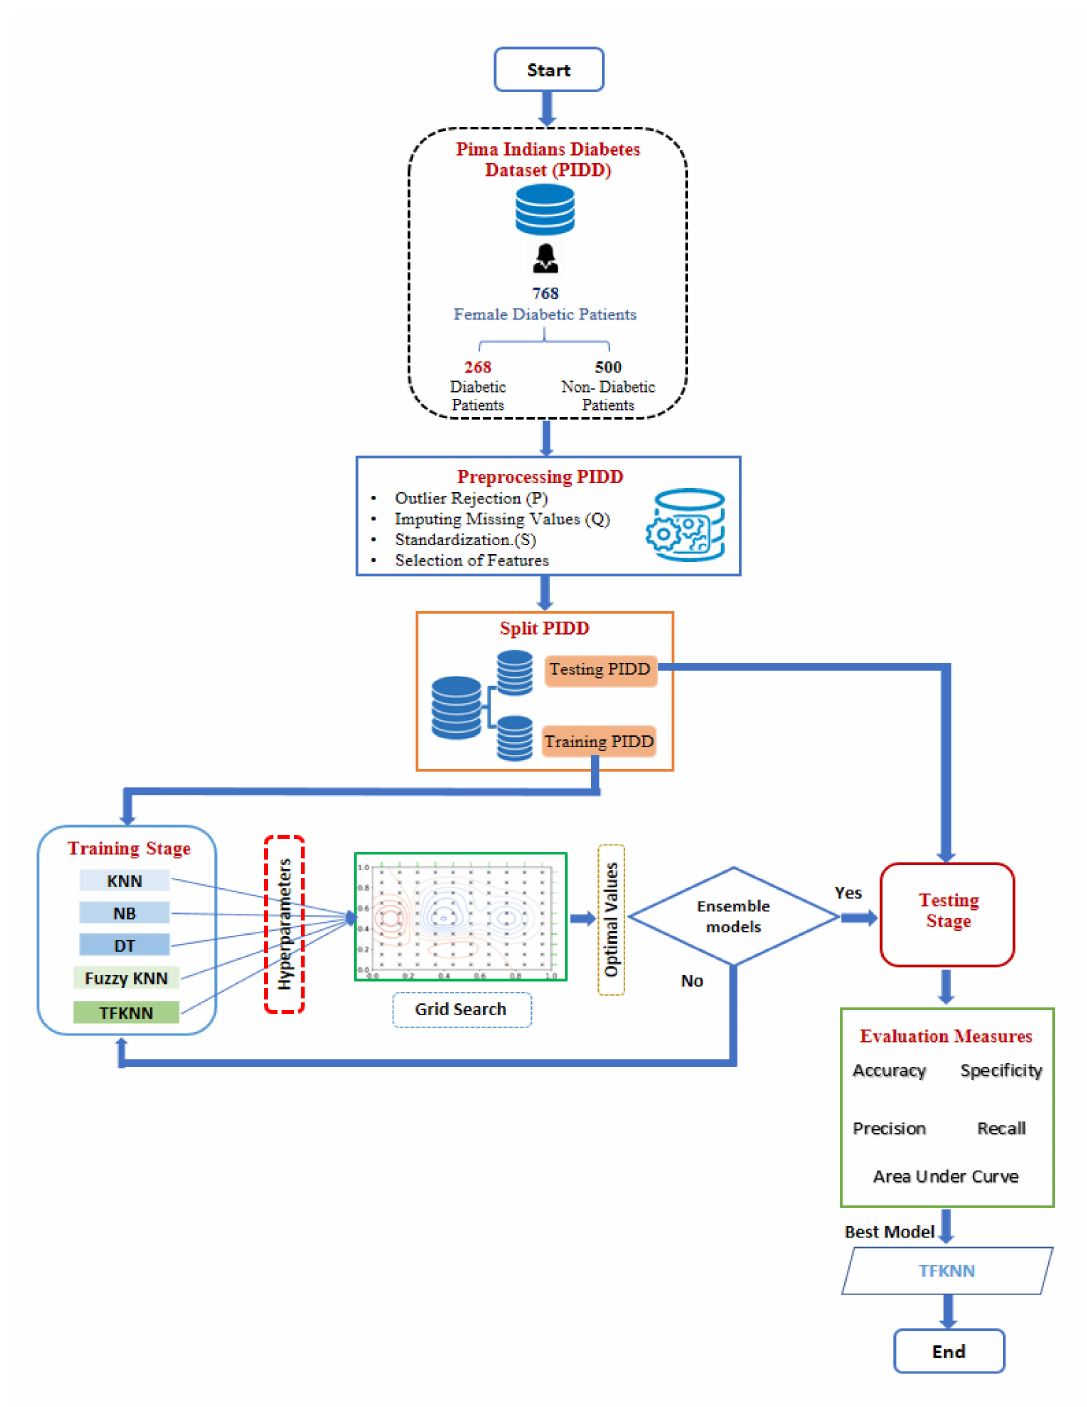
Figure 6. The proposed fine-tuning workflow to optimize the diabetes classification